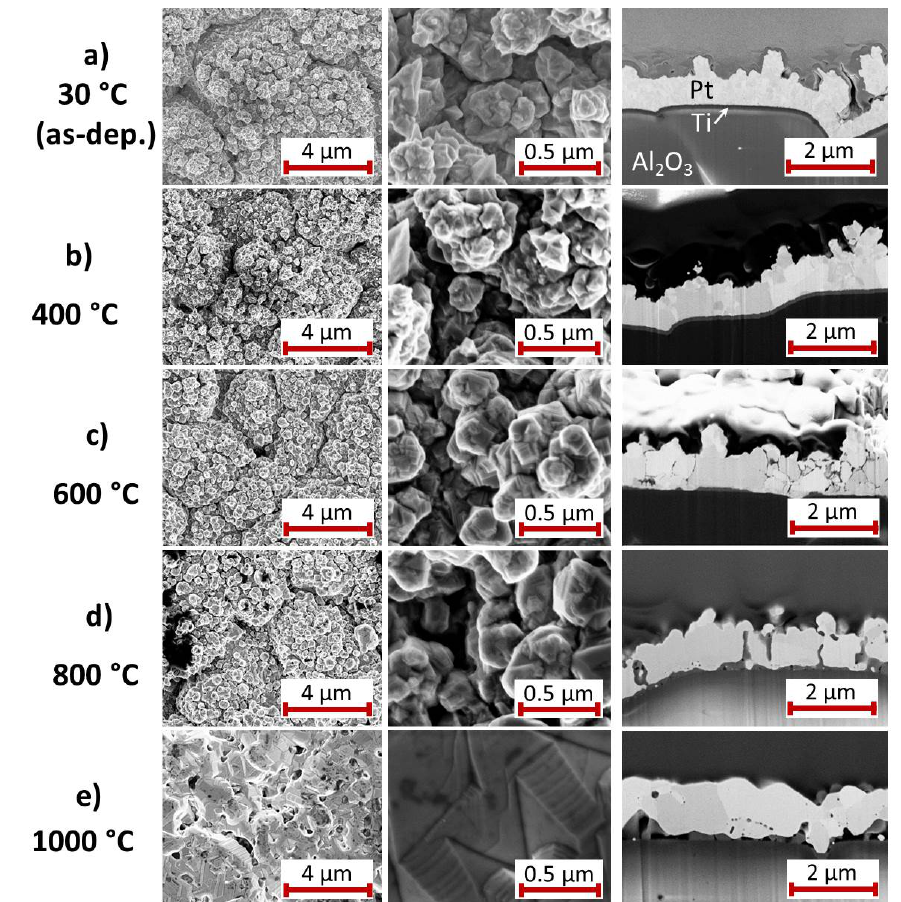
Figure 3. SEM images (InLens, 5 kV, 3 mm working distance) with two different magnifications of the surface of the electrodeposited Pt ∗ film on Ti seed layer ( a ) after deposition and after annealing for 2 h in air at ( b ) 400; ( c ) 600; ( d ) 800 and ( e ) 1000 ◦ C. On the right hand side a SEM image (InLens, 3 kV, 5 mm working distance) of the film cross-section is